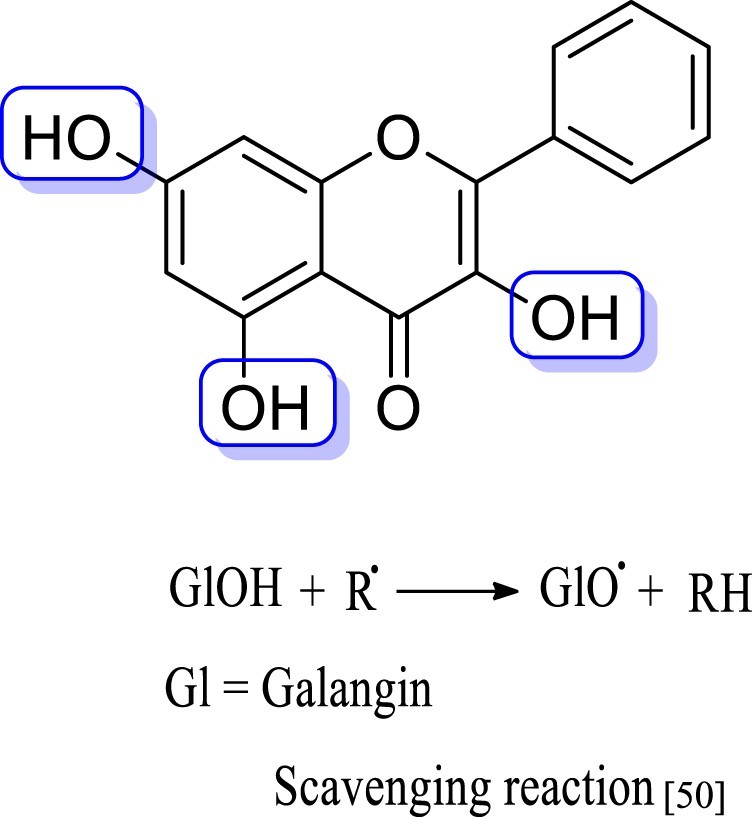
Galangin
structure.